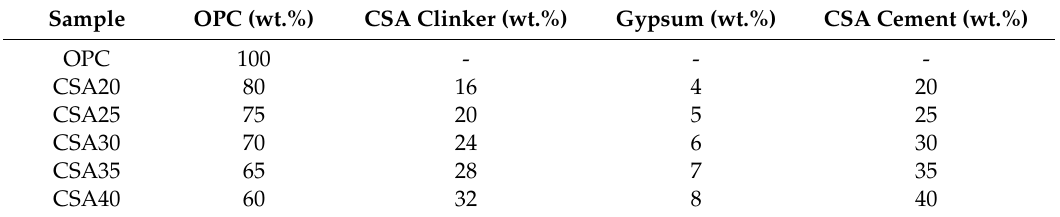
Table 1. Mix ratios of CSA / OPC blends for water requirement, setting times, and compressive strength tests.